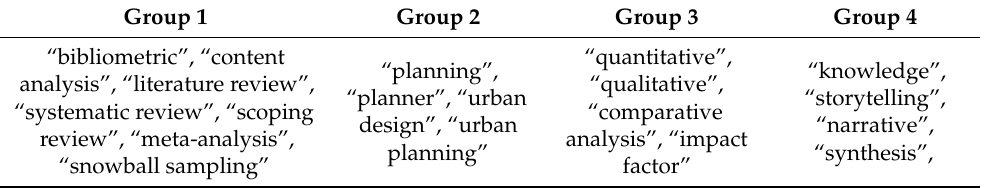
Table 3. Keywords for searching academic papers published within 2019–2022. Group